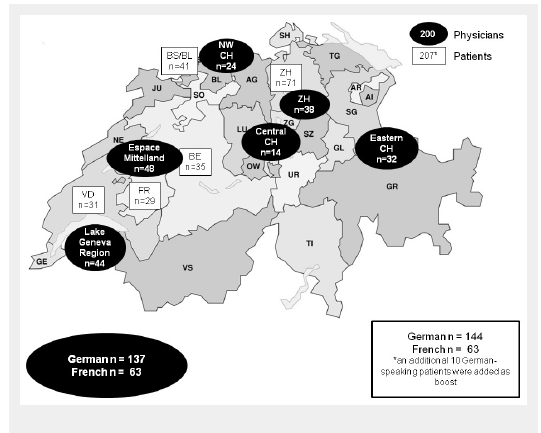
Figure 2 Regional distribution of study participants. Dark oval fields represent the physicians. White rectangular fields represent the patients. Abbreviations on the map represent the different cantons of Switzerland. Patients were recruited from Bern (BE), the Basel area (BS/BL), Fribourg (FR), Vaud (VD) and Zurich (ZH).